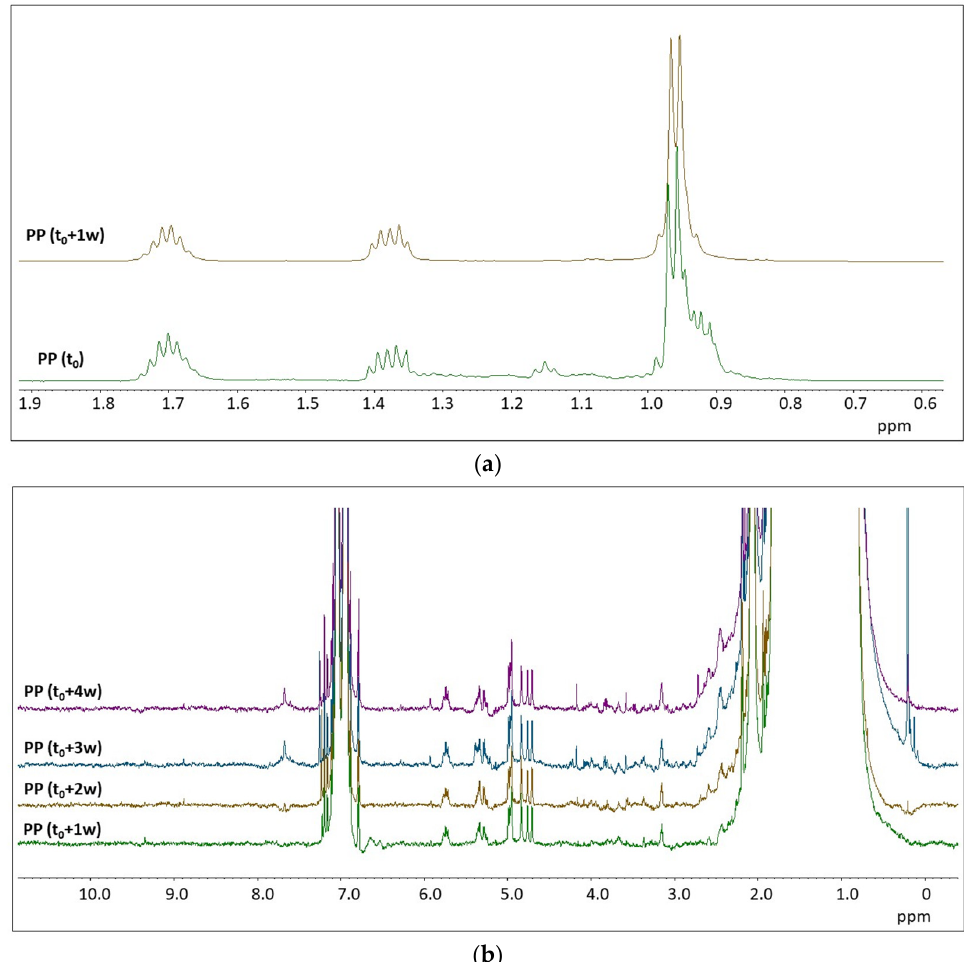
Figure 4. ( a ) 1 H NMR spectra of the pristine PP microplastics (t 0 ) and after 1 week of irradiation (t 0 + 1 w). ( b ) Stackplot of the 1 H NMR spectra of the PP microplastics at different times of irradiation (from bottom to top): t 0 + 1 w, t 0 + 2 w, t 0 + 3 w, and t 0 + 4 w, enlarged at the spectral baseline to see the presence of small signals. Spectra were normalized with respect to the aliphatic signal between 0.85 and 1.0 ppm (due to the CH 3 in the PP). Note that the signals around 7 ppm and 2.3 ppm are due to the deuterated solvent (toluene-d 8 ).